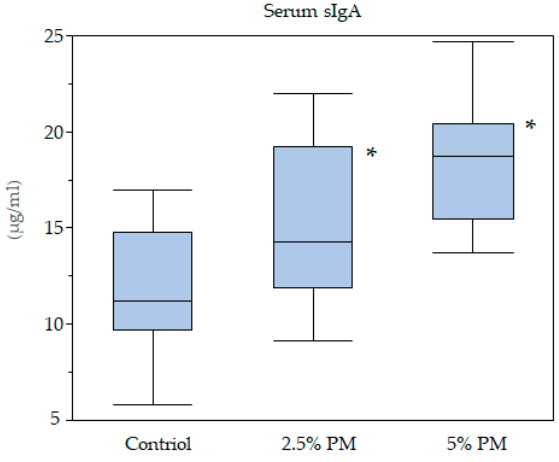
Figure 3. Box-whisker plot of serum sIgA concentrations. * PM increased sIgA levels in a dose dependent manner ( p <